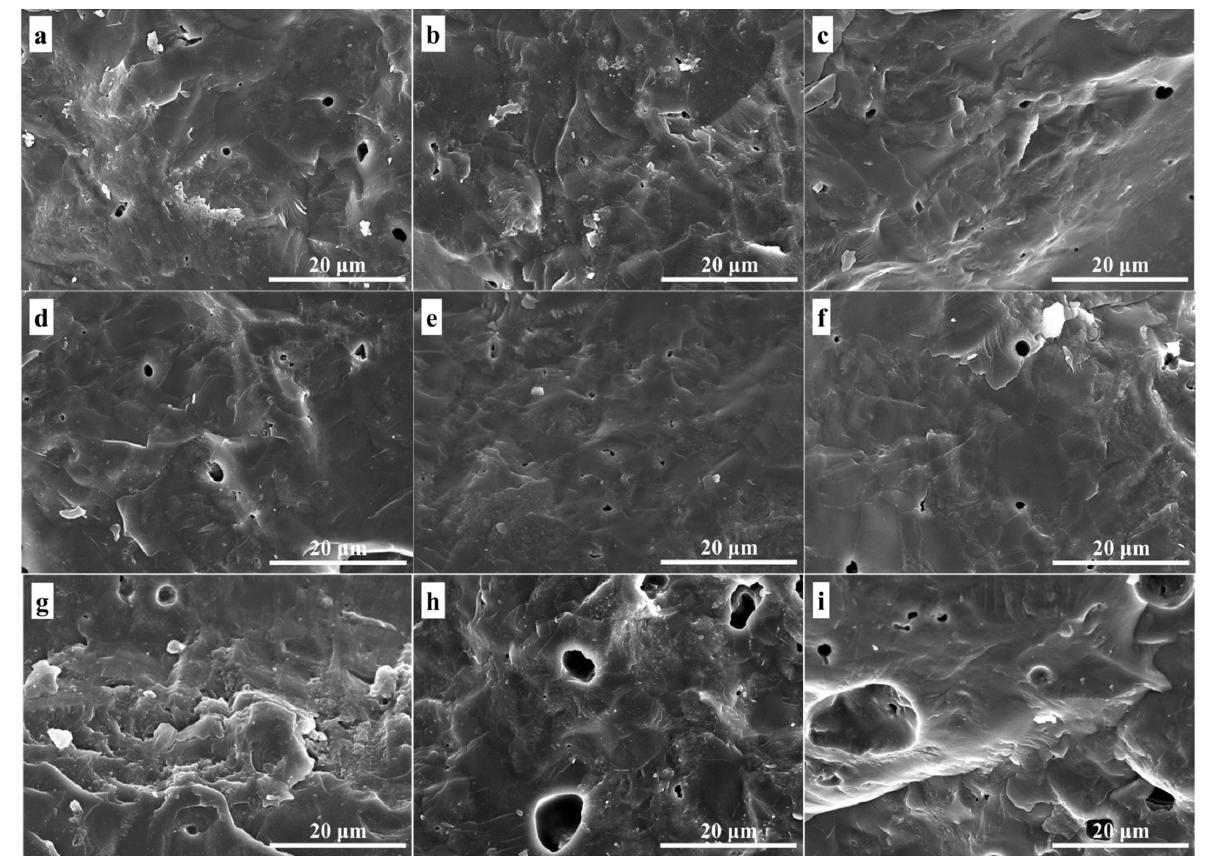
Figure 3. SEM images of fracture of glass-ceramics prepared from MAS40 ( a , d , g ), MAS45 ( b , e , h ), and MAS50 ( c , f , i ) at ( a – c ) 875 ◦ , ( d – f ) 900 ◦ C, and ( g – i ) 950 ◦ C.